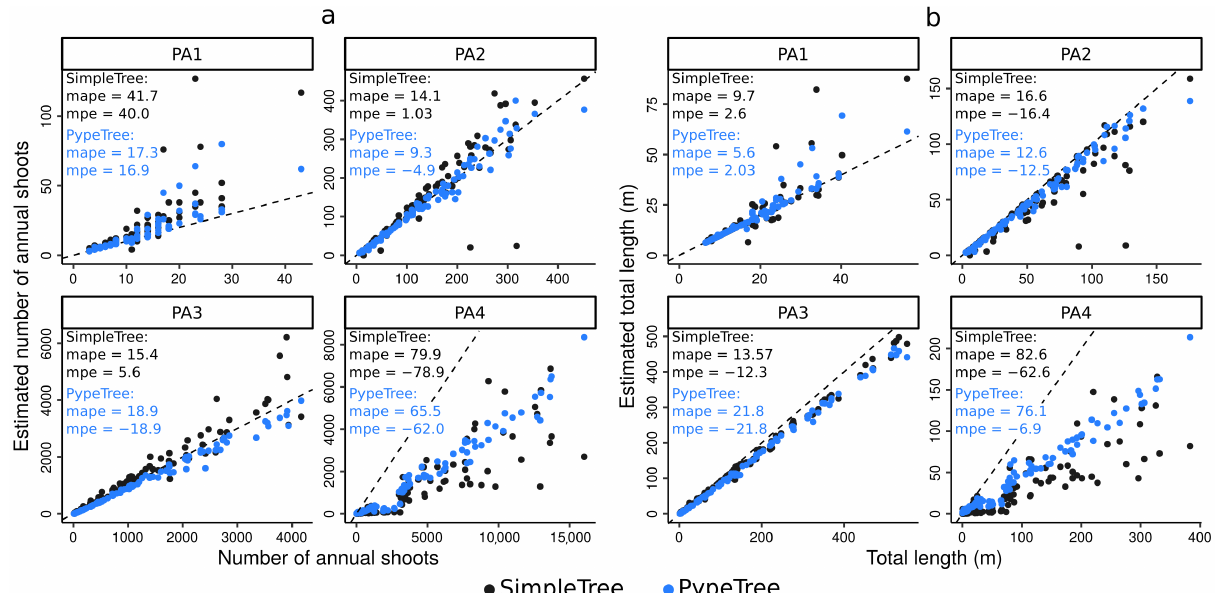
Figure 13. Evaluation of skeletonization and annual shoot segmentation in 110 simulated TLS scans of 110 simulated trees (5 to 15 years with 10 trees per age) reconstructed with two QSM methods. Number of segmented annual shoot ( a ) and total annual shoot length ( b ) in each physiological age (PA). Evaluations are done against the AS number and length observed in the output file of the AMAPsim model. The dotted line represents the 1:1 relation. The Mean Absolute Percentage Error (mape, %) and Mean Percentage Error (mpe, %) are indicated on the